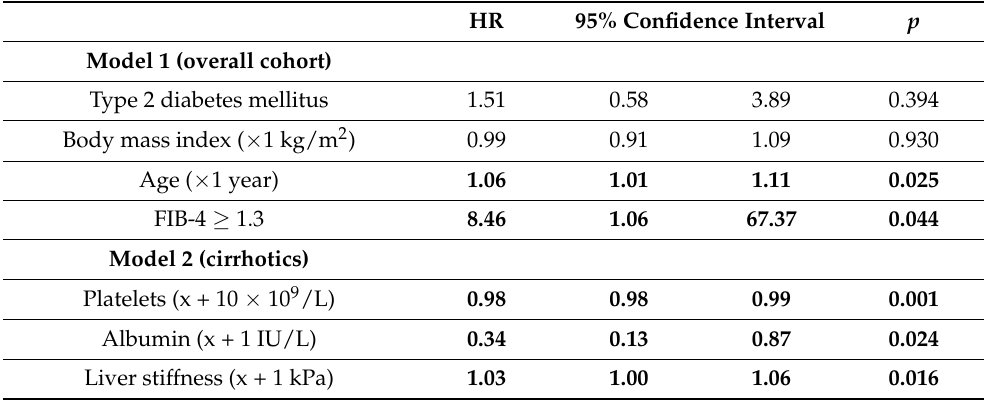
Table 4. Summary of the multivariable analyses of factors associated with the incidence of hepatocel- lular carcinoma in NAFLD patients. HR 95% Confidence